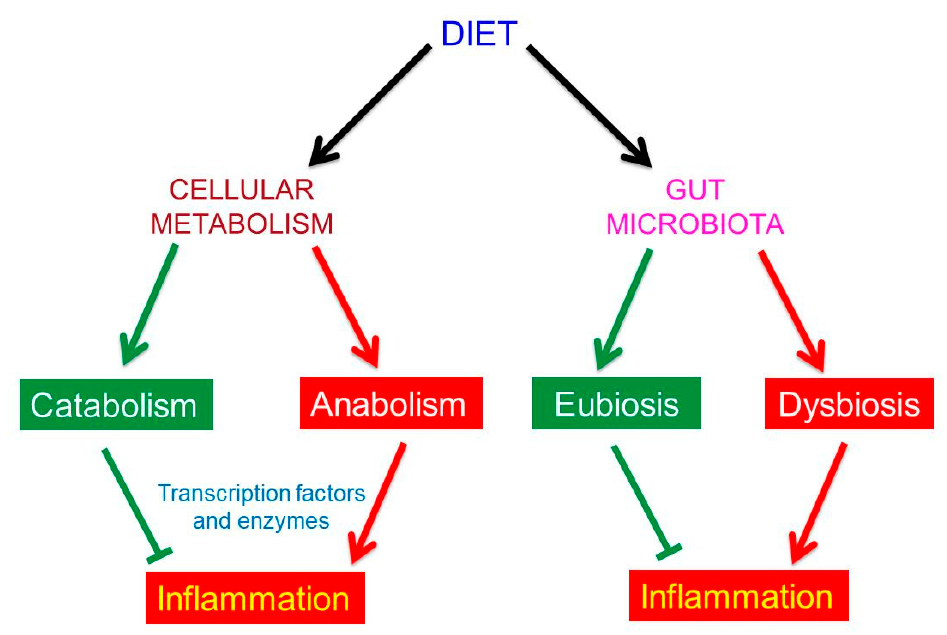
ff ect both our metabolism and the composition of our gut Figure 2. Dietary habits affect both our metabolism and the composition of our gut microbiota. Figure 2. Dietary habits a